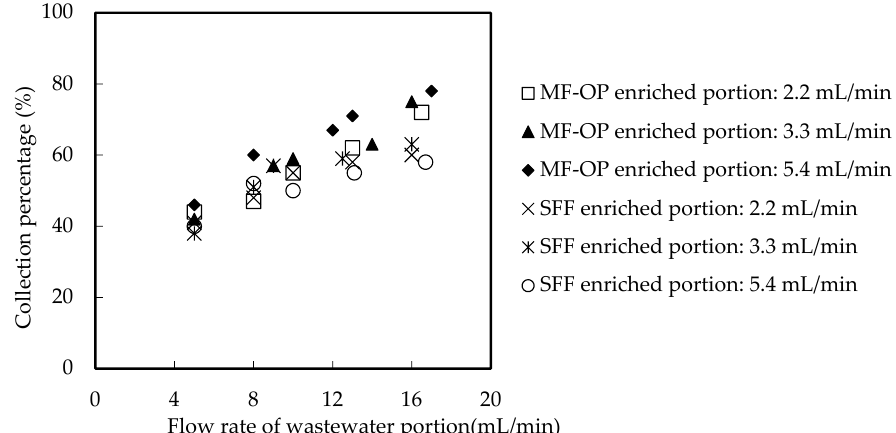
Figure 4. The comparison between MF-OP and traditional SLM for current speeds influence on collection of Ho(III) in both portions (I).